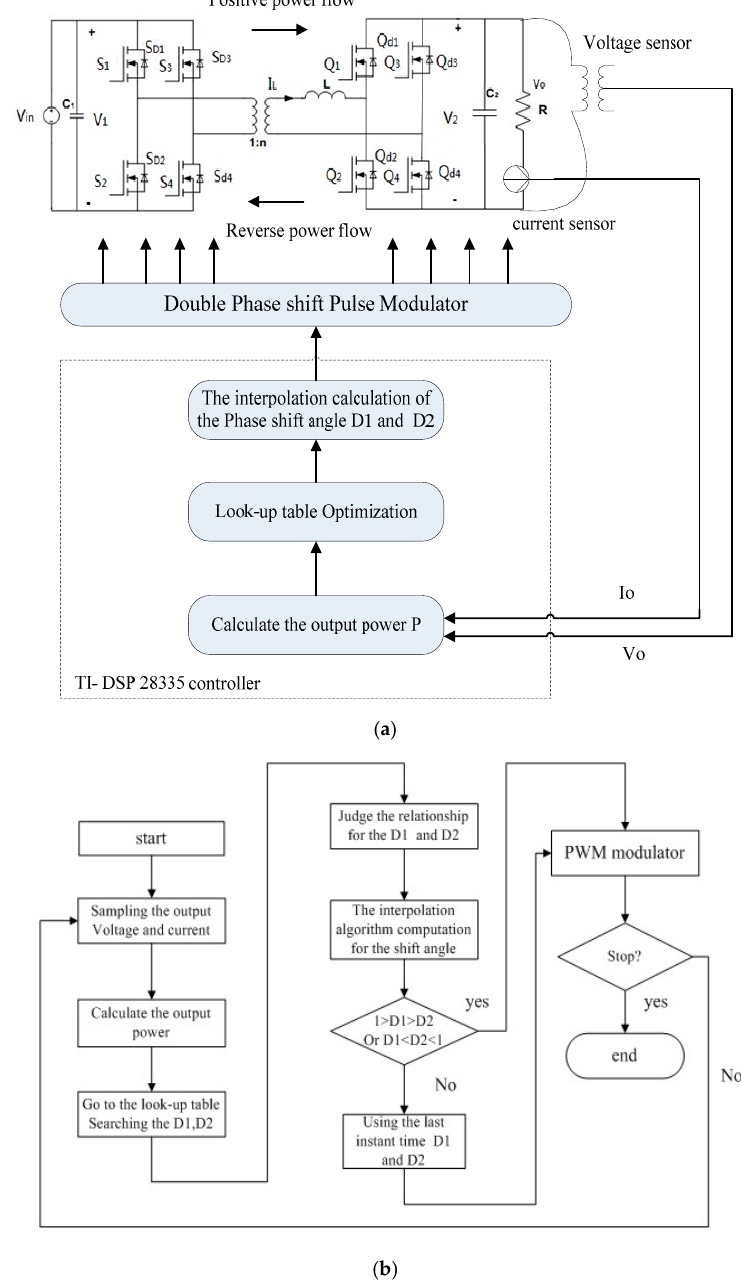
Figure 6. ( a ) Proposed control block diagram; ( b ) The flow chart for the algorithm.